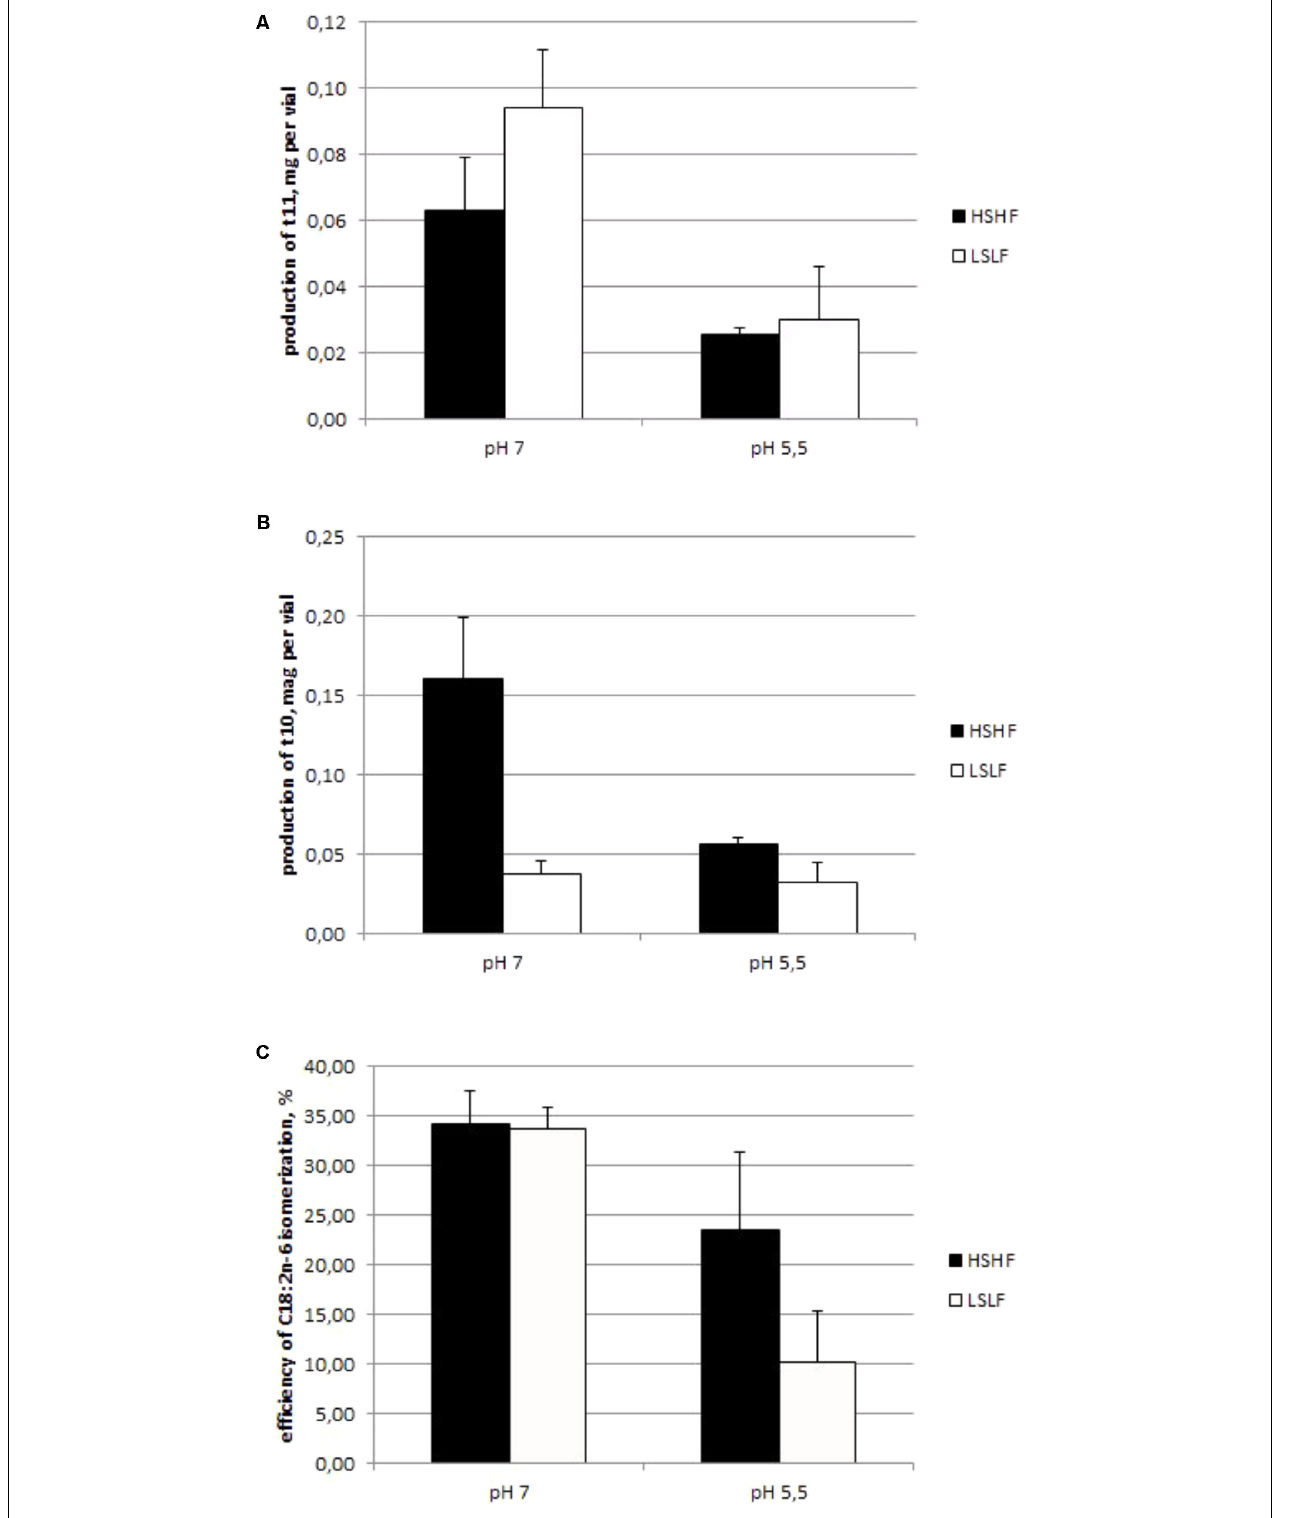
FIGURE 3 | Production (mg) of t11 (A) and t10 (B) isomers, and C18:2n-6 isomerization efficiency ( C , %) in a chloramphenicol-treated ruminal content of a cow fed either with a HSHF or a low fat low starch diet (FSLF) and incubated with a high (7.0) or a low (5.5) pH buffer (mean ± SD, Experiment 1.3).